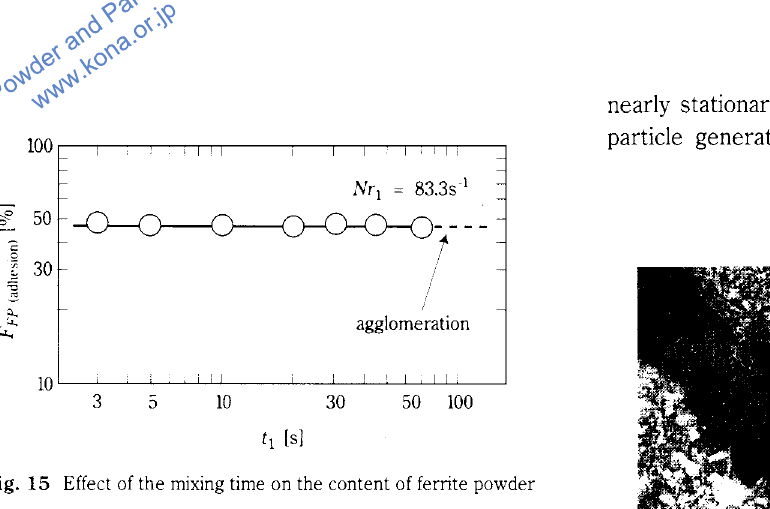
Fig. 15 Effect of the mixing time on the content of ferrite powder